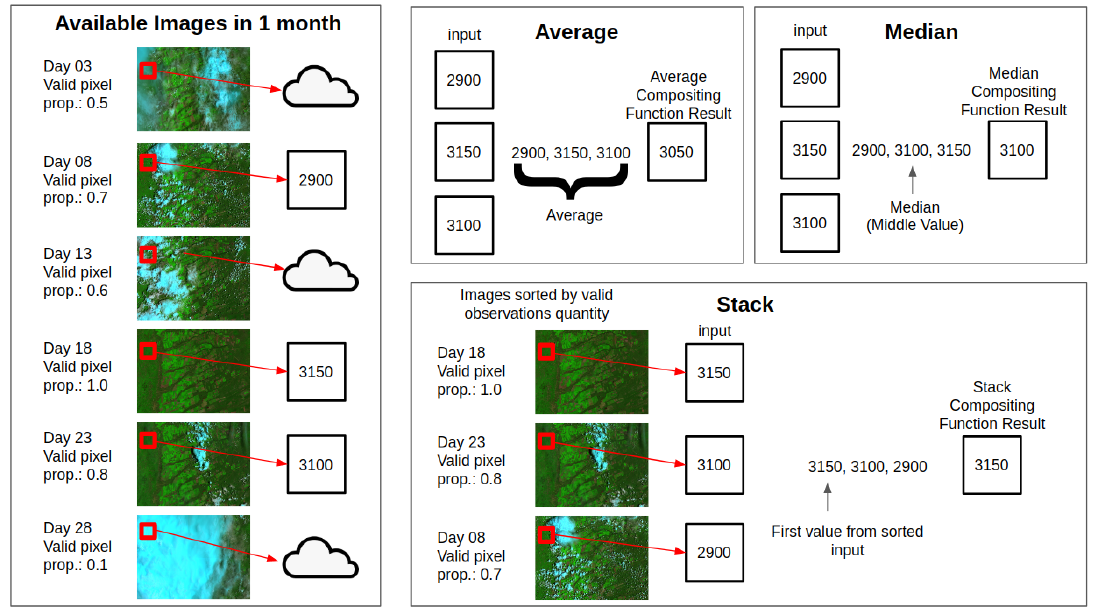
Figure 5. Brazil Data Cube time composing functions (average, median, and stack) applied on a pixel obtained from a monthly time